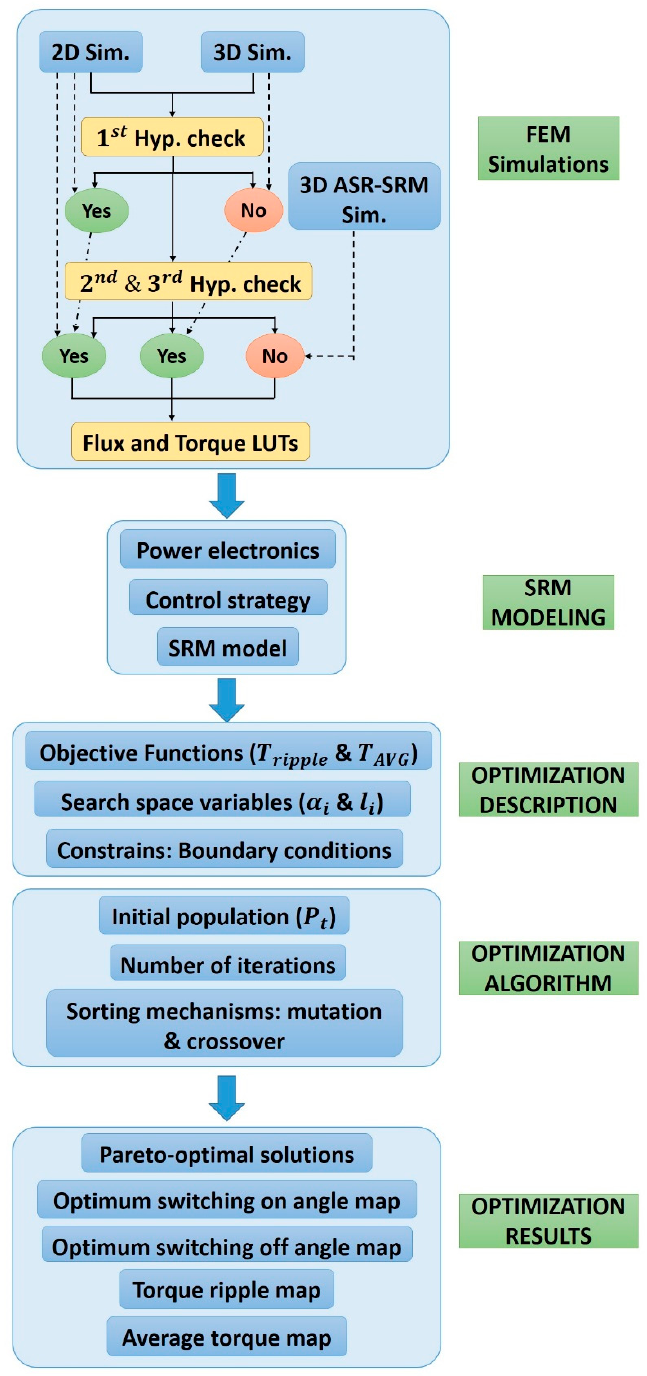
Figure 14. Flowchart of the multi-objective optimization methodology.